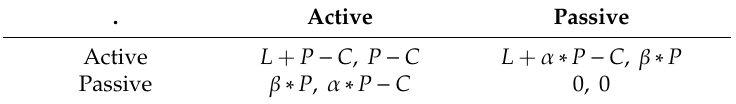
Table 5. Payo ff matrix A for 2 × 2 (Scrum Master vs. other team members (OTM)) game.